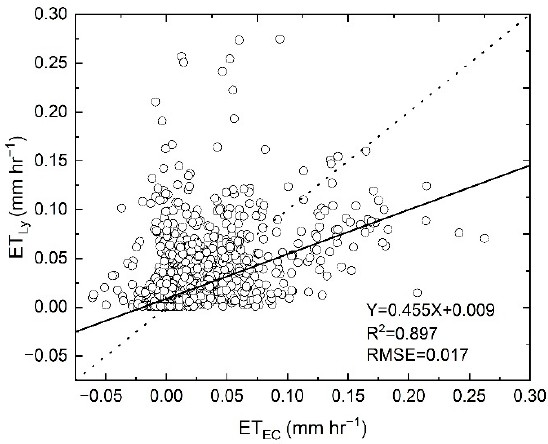
Figure 7. Comparison of evapotranspiration data measured by eddy covariance ( ET EC ) and lysimeter observation ( ET ly ) at the same site in the Qinghai Lake Basin from 11 February to 10 April